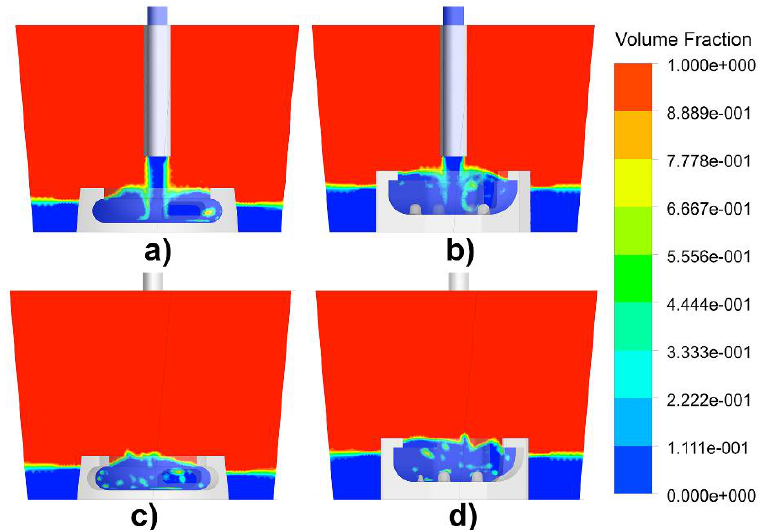
Figure 6. Volume fractions of gas phase in the two-phase flow during tundish filling operations: ( a ) TI1, plane passing through the ladle shroud axis; ( b ) TI3 plane passing through the ladle shroud axis; ( c ) TI1 plane located at half the distance between the center of the tundish and the wall of the inhibitor; ( d ) TI3 plane located at half the distance between the center of the tundish and the wall of the inhibitor.